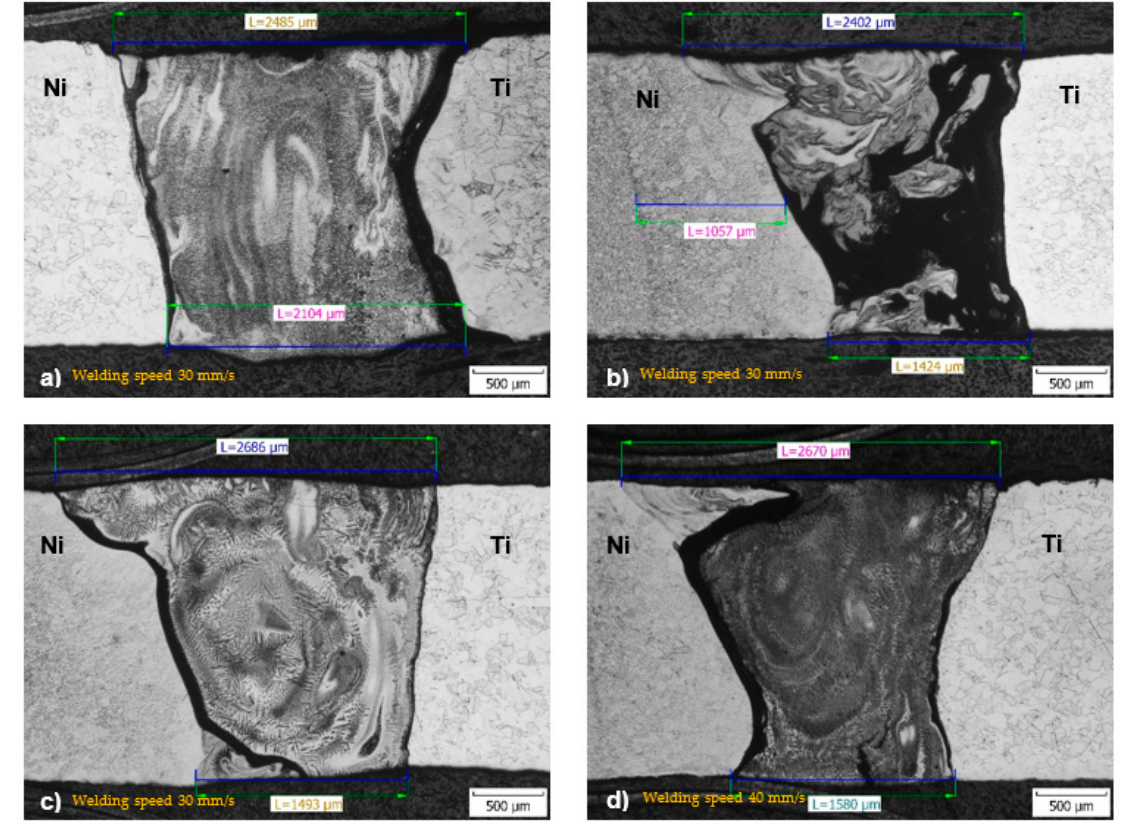
Figure 6. Cross-sections of weld joints produced with different welding parameters. Samples 1 ( a ), 6 ( b ), 8 ( c ), 10 ( d )